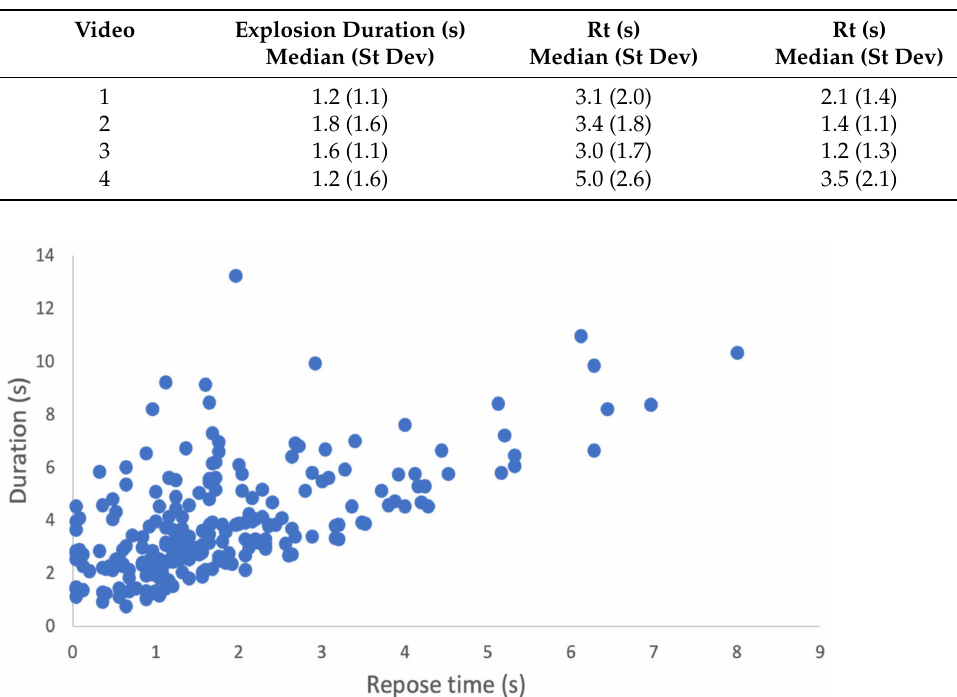
Table 3. Main temporal parameters of the Strombolian explosions. St Dev = Standard Deviation.